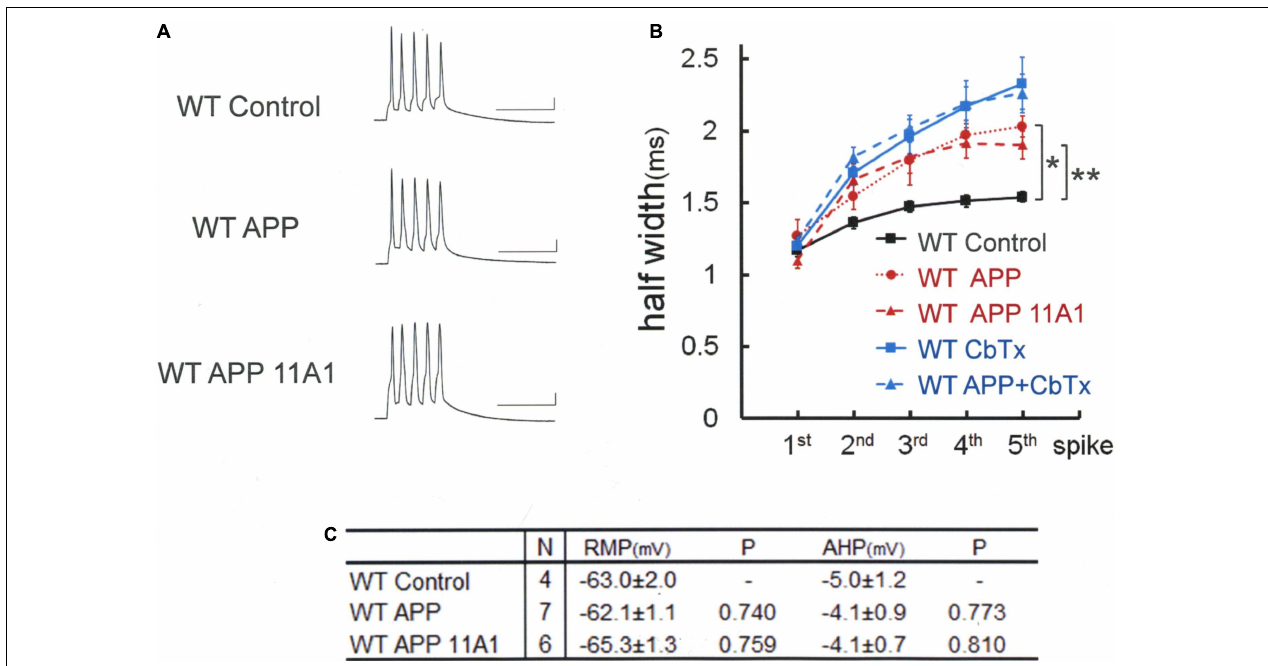
FIGURE 4 | Intracellular application of APP broadens spike width independently of APP-derived A β oligomer. (A) Specimen recordings of spike trains in WT mouse neurons. Scale bars, 50 ms and 20 mV. (B) Averaged spike half-width during the five-spike train (black line and square, WT Control; red dotted line and circle, WT APP; red dashed line and triangle, WT APP 11A1). Both in the WT APP and WT APP 11A1 groups, spike half-widths in 5th spikes are significantly broadened compared with WT Control (* P < 0.001, ** P = 0.004, respectively). For the “WT Control” specimen recording and numerical data, those shown in Figure 1 are reproduced for clarity. The blue lines indicate that the APP effect is occluded by a prior application of the charybdotoxin (CbTx), with the solid and dashed lines representing the CbTx alone and the APP + CbTx groups, respectively. (C) Basic membrane properties of recorded neurons. Convention is the same as in Figure 1